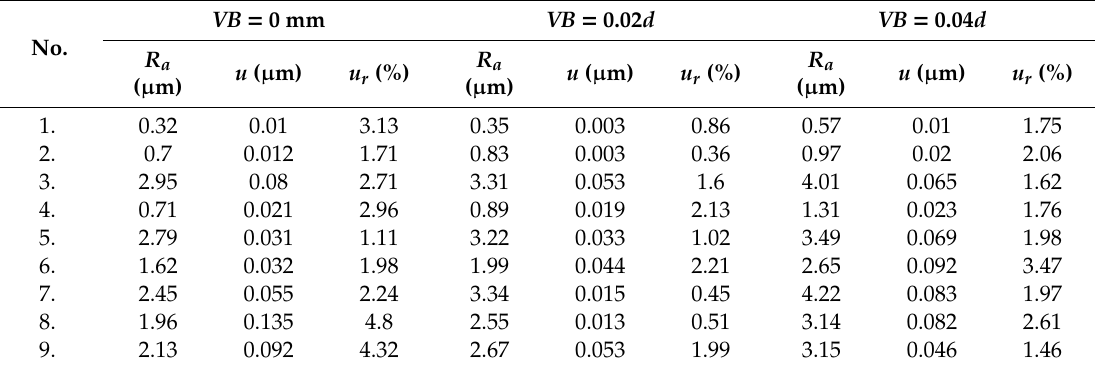
Table 7. Measurement uncertainties for R a values.